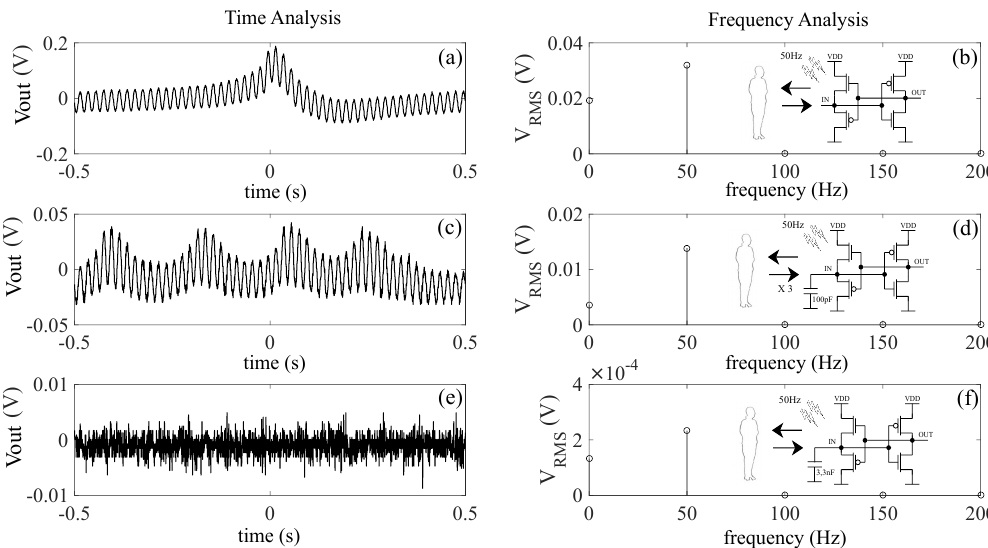
Figure 20. Susceptibility of the PFGA to the Electromagnetic (EM) interferences. Signals measured at the output node of the PFGA: ( a ) 50 Hz noise and low frequency noise produced by the presence of a human body. ( b ) FFT of the signal in ( a ). ( c ) 50 Hz noise and low frequency noise produced by the presence of a human body with C IN = 100 pF. ( d ) FFT of the signal in ( c ). ( e ) 50 Hz noise and low frequency noise produced by the presence of a human body with C IN = 3.3 nF. ( f ) FFT of the signal in ( e